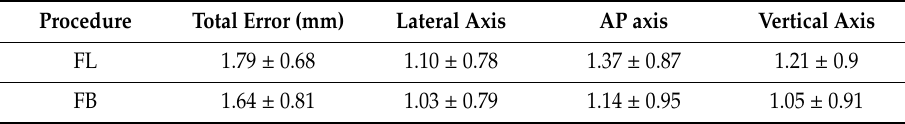
Table 1. Accuracy of the procedures FB (fiducial-based) FL